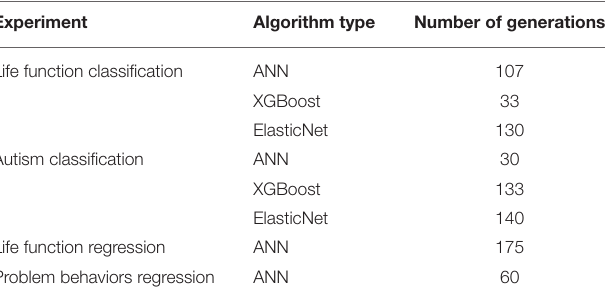
TABLE 7 | Hyperparameter values after tuning with IEL. Algorithm type and hyperparameters